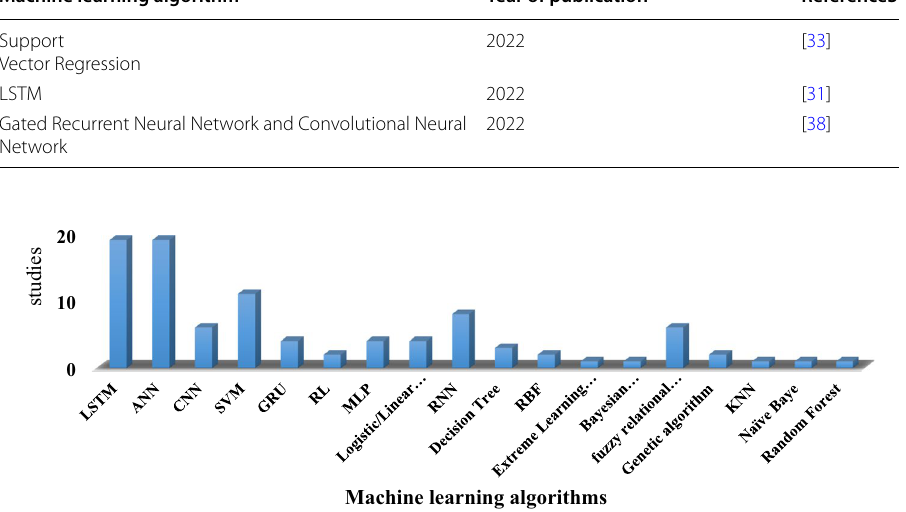
Table 5 Table showing machine learning algorithms use in the year 2022 Machine learning algorithm